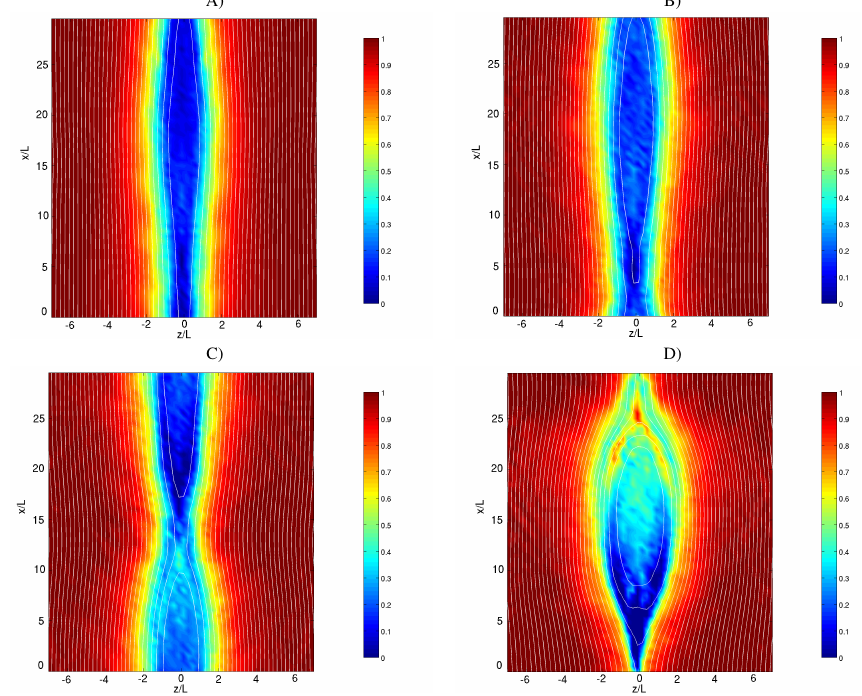
Fig. 2. Non-linear evolution of the initial force-free reversed field equilibrium. Velocity component (false colour) away from the Sun (in the frame of reference of the Sun) and magnetic field lines (white) are shown at four different times (A: t/τ A = 143 , B: t/τ A = 215 , C: t/τ A = 229 , D: t/τ A = 251 ) in a run with S = 10 4 and R v = 10 4 .